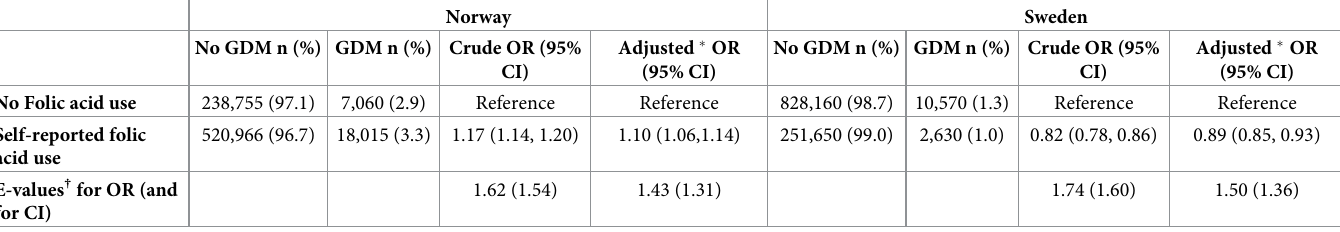
Table 3. Crude and adjusted odds ratios and 95% confidence intervals estimating the association between self-reported folic acid use and gestational diabetes in mothers from Norway and